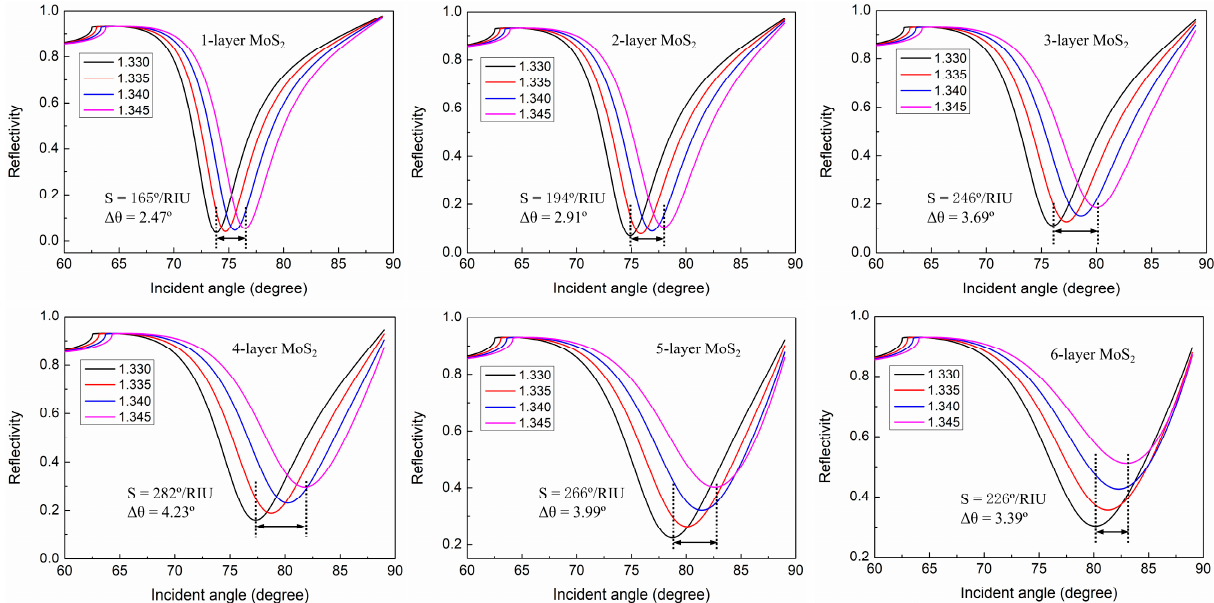
Figure 3. Reflectivity curves change with incident angles for graphene–MoS 2 hybrid-structure sensor